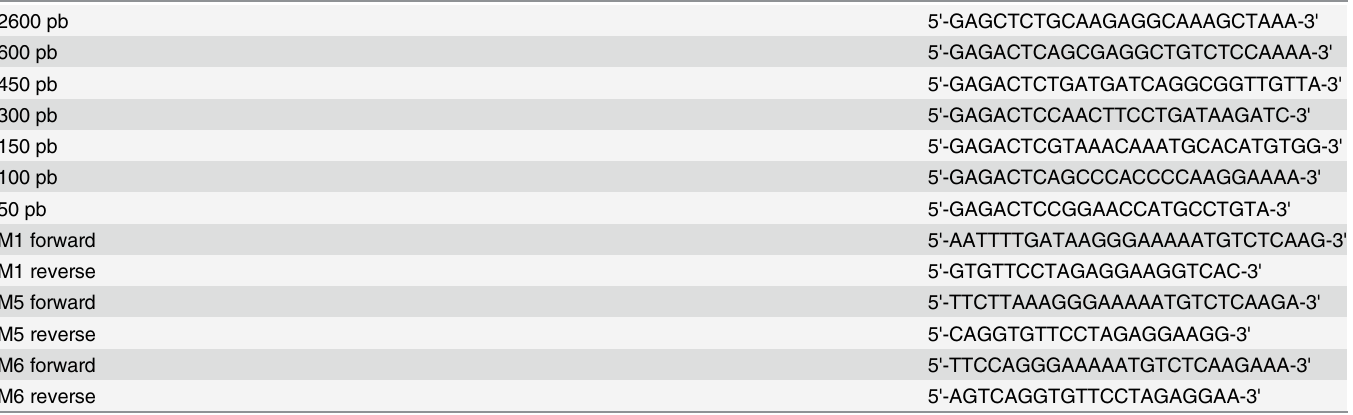
Table 1. Oligonucleotides used for construction of deleted mutants and site-directed mutagenesis of the Syncytin-2 promoter. 2600 pb 600